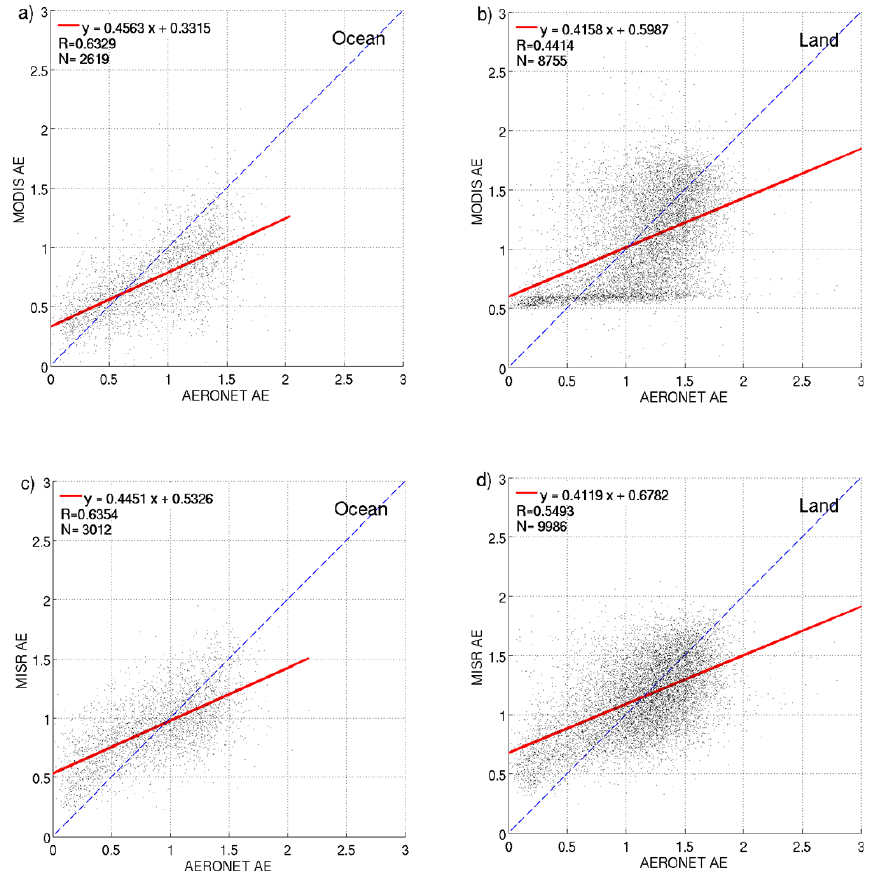
Fig. 3. Comparison of monthly AERONET AE and monthly MODIS (or MISR) AE. The data on the T42 resolution are used